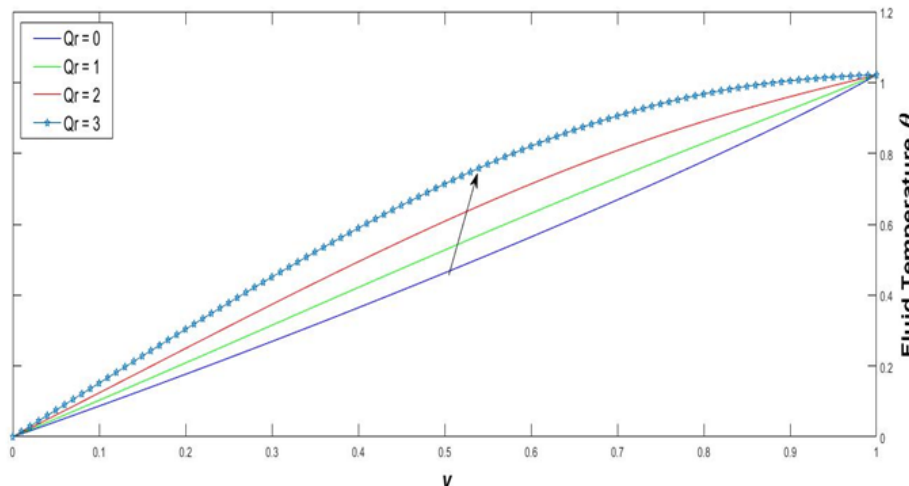
Figure 17. Velocity field for various Radiation parameters.